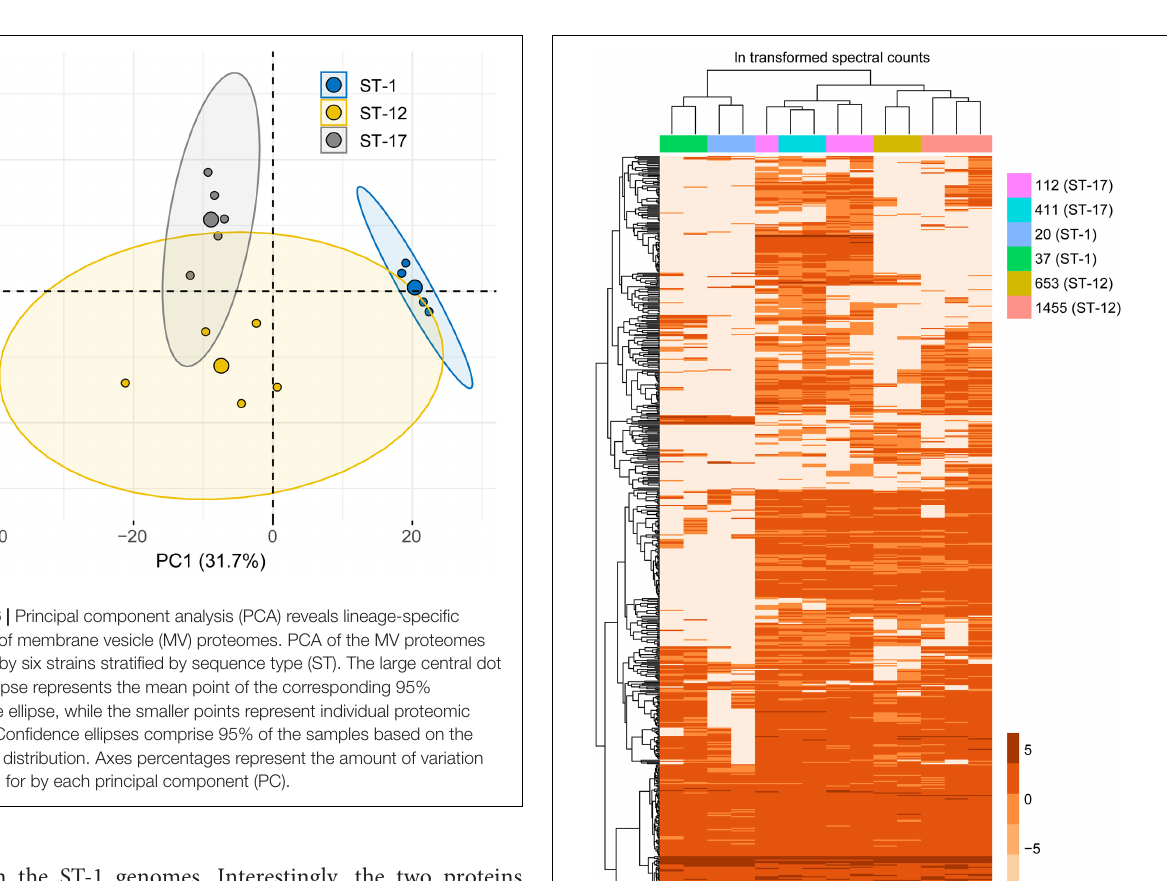
and clinical phenotype was analyzed ( Supplementary Figure 3